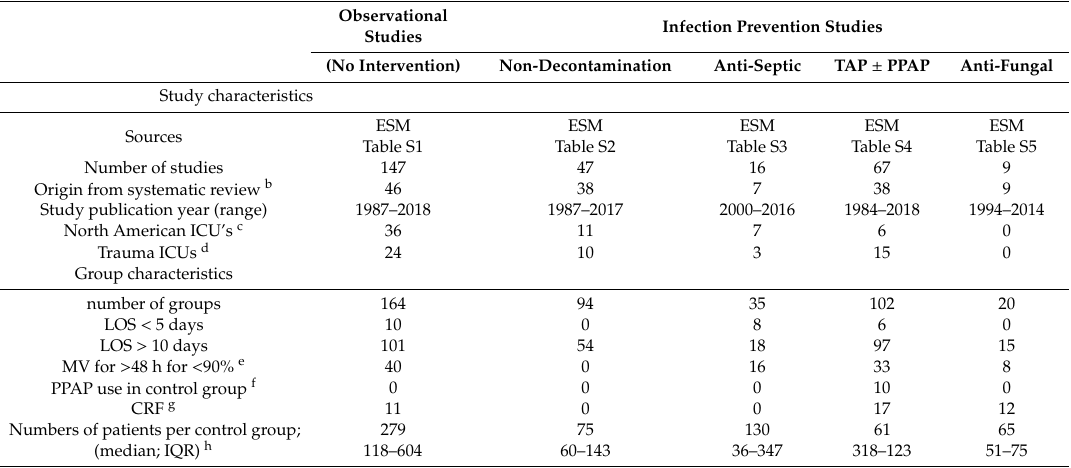
Table 1. Characteristics of studies a .